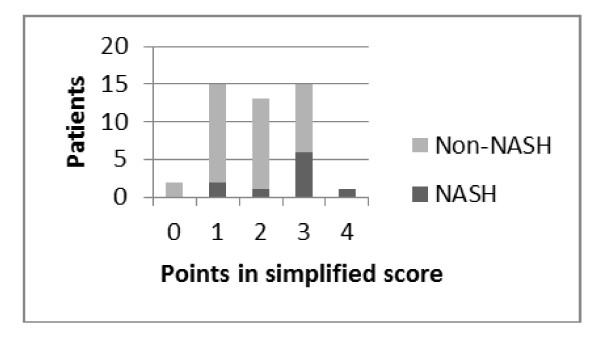
Number of patients with NASH according to the number of points in complete score system.